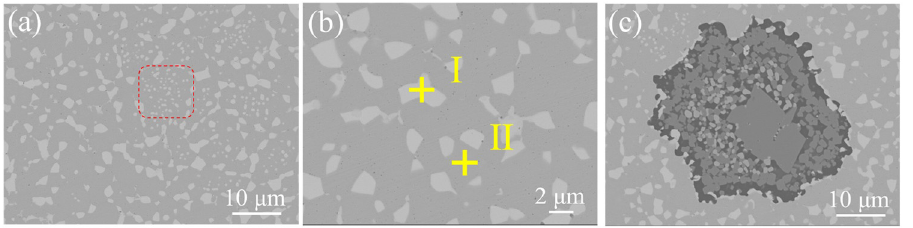
Figure 6: ( a ) SEM - BSE image of the microstructure in N - HT alloy, ( b ) the magni fi cation, and ( c ) the irregular black - gray region.